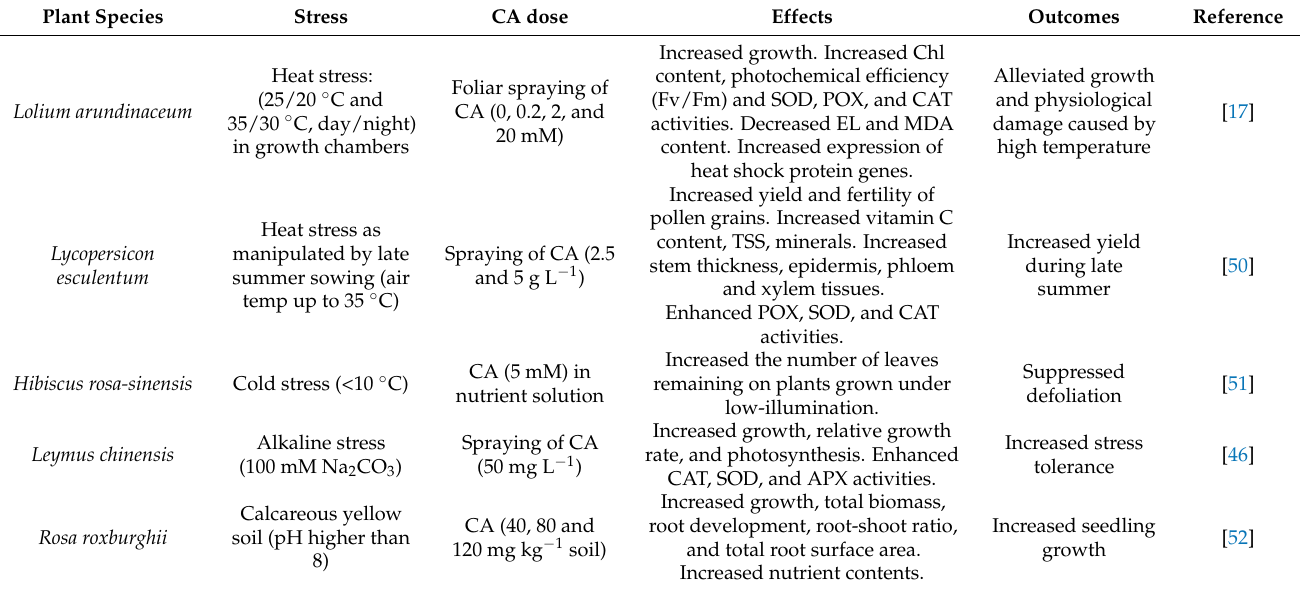
Table 3. Effectiveness of exogenous CA on mediating temperature and alkaline stress